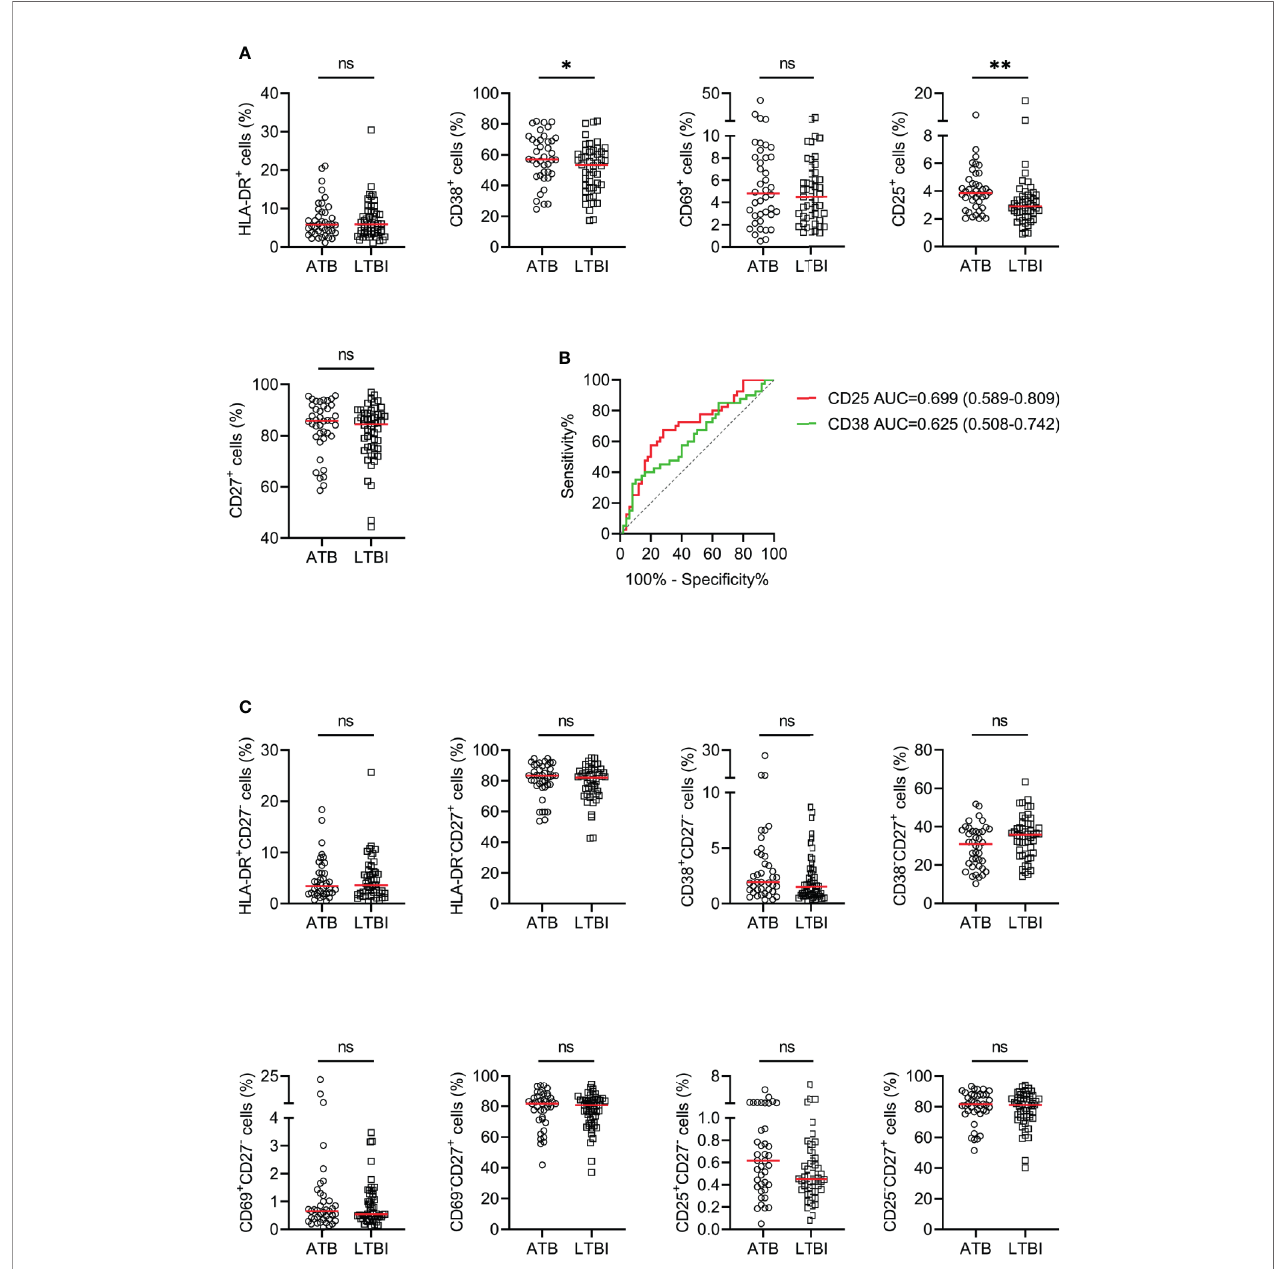
FIGURE 3 | The performance of various markers on CD4 + T cells in distinguishing ATB patients from LTBI individuals in Qiaokou cohort. (A) Scatter dot plots showing the results of the expression of HLA-DR, CD38, CD69, CD25, and CD27 on CD4 + T cells in ATB patients and LTBI individuals. Horizontal lines indicate the medians. (B) ROC analysis showing the performance of the expression of CD38 and CD25 on CD4 + T cells in discriminating ATB patients from LTBI individuals. (C) Scatter dot plots showing the results of the proportions of HLA-DR + CD27 - cells, HLA-DR - CD27 + cells, CD38 + CD27 - cells, CD38 - CD27 + cells, CD25 + CD27 - cells, and CD25 - CD27 + cells of CD4 + T cells in ATB patients and LTBI individuals. Horizontal lines indicate the medians. * P < 0.05, ** P < 0.01, ns, no signi fi cance (Mann- Whitney U test). MTB, Mycobacterium tuberculosis ; ATB, active tuberculosis; LTBI, latent tuberculosis infection; AUC, area under the